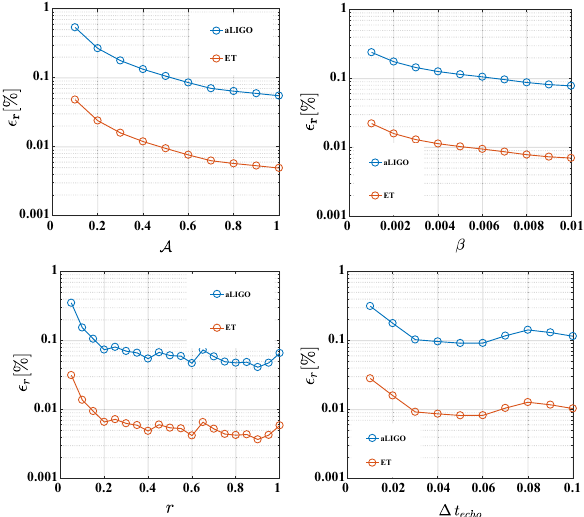
Fig. 6 Relative errors on r in the UIE template, computed with fore- cast Advanced LIGO at final design sensitivity (blue) and ET with the forecast sensitivity